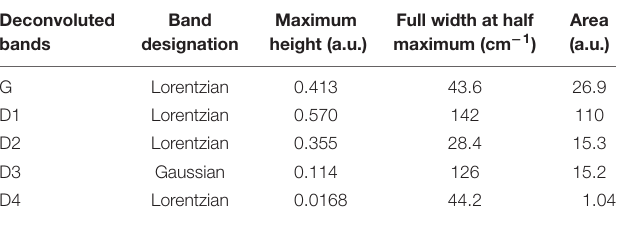
TABLE 1 | Parameters of amorphous carbon